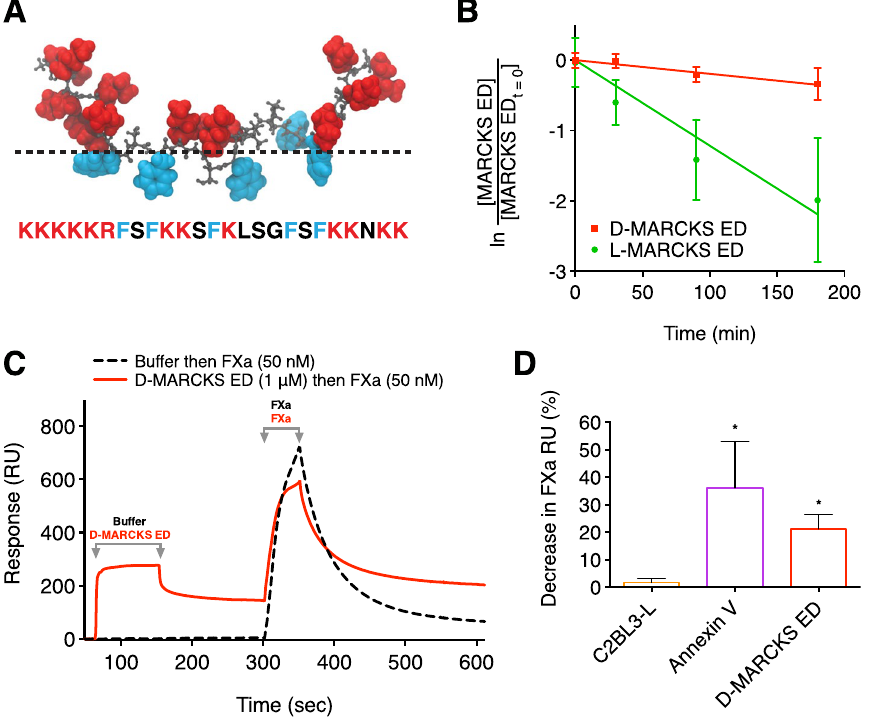
Figure 1. D-MARCKS ED is a protease resistant peptide that antagonizes the binding of FXa to PS. ( A ) Sequence and representative membrane bound conformation of the MARCKS ED peptide. Positively charged residues are shown in red and phenylalanine residues are shown in blue. Dashed line shows approximate location of the membrane lipid head groups. ( B ) Comparison of the human serum stability of L-MARCKS ED ( t 1/2 = 57 min, 95% confidence interval (CI) 46 to 79 min) and D-MARCKS ED ( t 1/2 = 356 min, 95% CI 252 to 606 min) peptides ( n = 3, mean ± SD). ( C ) Representative reference corrected Biacore 3000 SPR sensogram showing D-MARCKS ED antagonizes the binding of FXa to lipid membrane surface containing PS. Dashed black line shows an injection of running buffer at t = 30 sec and an injection of 50 nM FXa at t = 300 sec. Following complete dissociation of FXa from the membrane surface, the solid red line shows an injection of 1 μ M D-MARCKS ED at t = 30 sec and an injection of 50 nM FXa at t = 300 sec. ( D ) Quantification of FXa SPR binding inhibition with BiOptix 404pi instrument by negative control C2BL3-L, positive control annexin V, and D-MARCKS ED ( n = 3 C2BL3-L and annexin V; n = 5 D-MARCKS ED, mean ± SD). * P < 0.05 compared to C2BL3-L by Kruskal-Wallis test followed by Dunn’s post hoc